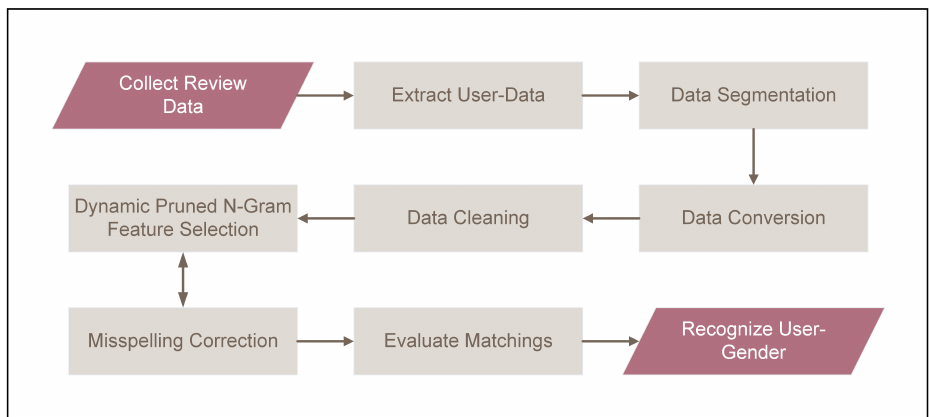
Figure 1. The Experimental Framework of the Gender Identification